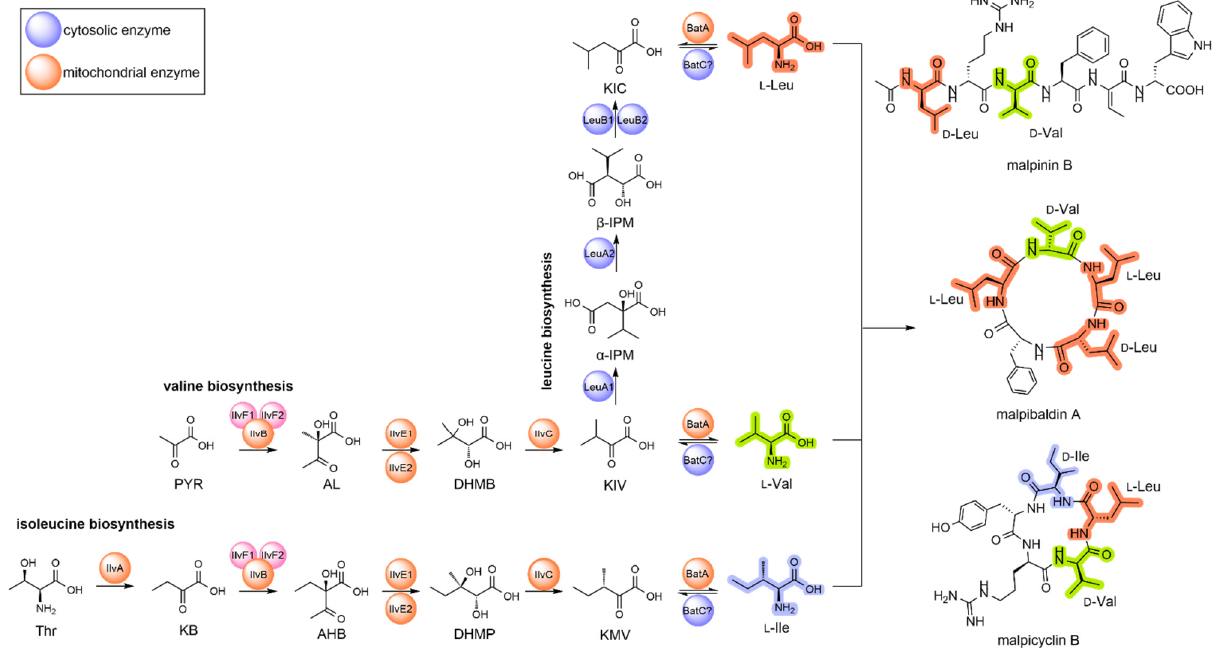
Figure 1. Proposed BCAA biosynthesis pathway and interconnection to the secondary metabolism in M. alpina . The proteins that participate in the pathway are (in alphabetical order): BatA (mitochondrial BCAA aminotransferase), BatC (cytosolic BCAA aminotransferase), IlvA (threonine dehydratase/deaminase), IlvB (acetolactate synthase, large subunit), IlvC (dihydroxy acid dehydratase), IlvE (acetohydroxy acid reductoisomerase), IlvF (acetolactate synthase, small subunit), LeuA1 ( α -isopropylmalate synthase), LeuA2 (isopropyl malate isomerase), and LeuB1/2 (two β -isopropyl malate dehydrogenases). The precursors, intermediates, and final products are (in alphabetical order): AHB (( 2S )-2-aceto-2-hydroxy-butyrate), AL (( 2S )-acetolactate), DHMB (( 2R) -2,3-dihydroxy-3-methyl-butyrate), DHMP (( 2R, 3R)- 2,3-dihydroxy-3-methyl-pentanoate), α -IPM (( 2S )- α -isopropyl malate), Ile ( L -isoleucine), β -IPM (( 2R, 3S )- β -isopropyl malate), KB ( α -ketobutyrate), KIC ( α -ketoisocaproate), KIV ( α -keto-isovalerate), KMV (( 3S )- α -keto-3-methyl-valerate), Leu ( L -leucine), PYR (pyruvate), Thr ( L -threonine), and Val ( L -valine). Mitochondrial and cytosolic enzymes are highlighted in ochre and azure, respectively. For more details on the proteins, refer to Table 1.